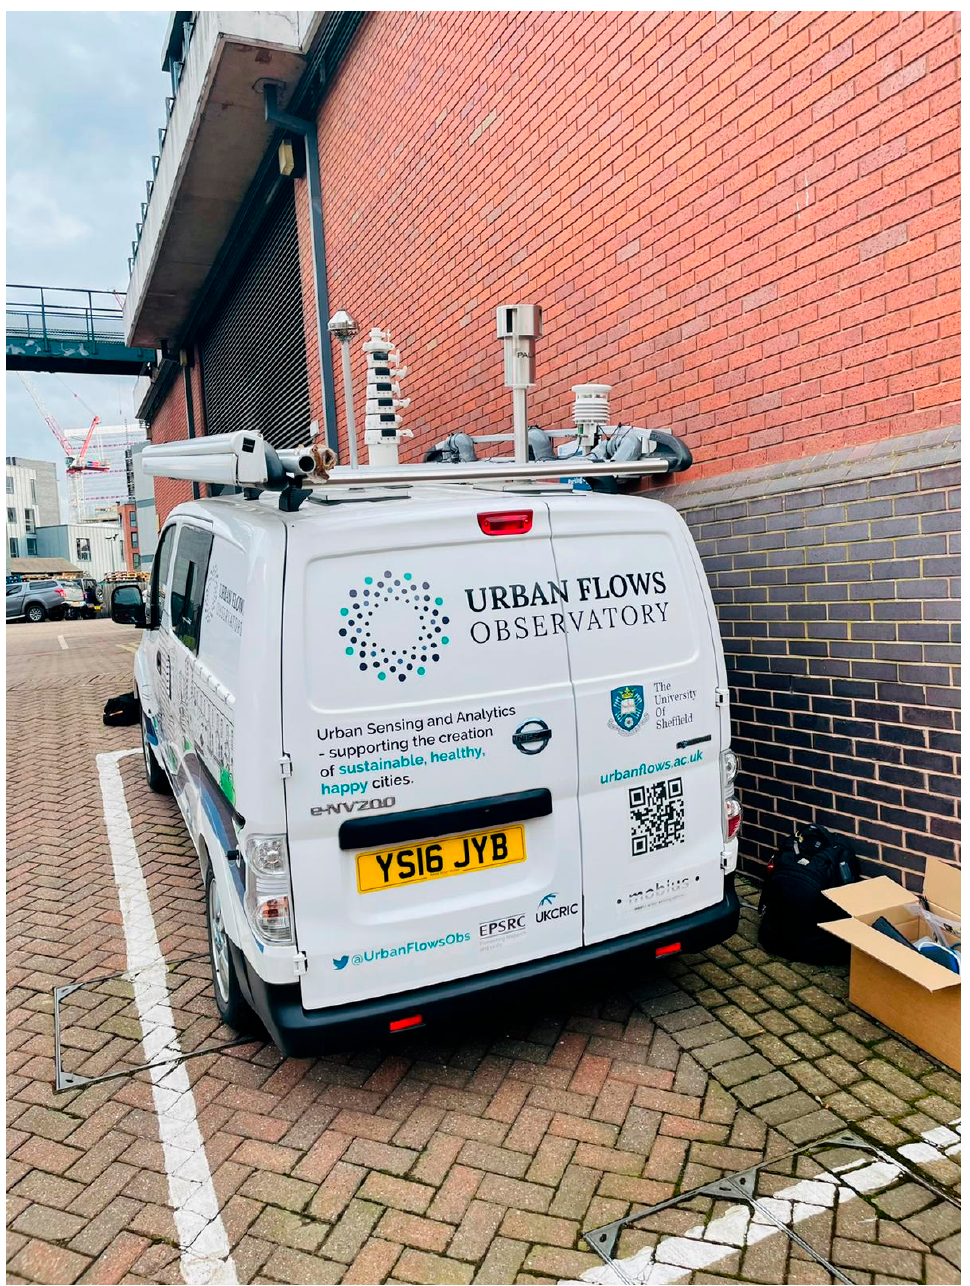
Figure 3. LCS-based AQ monitoring devices using RPi 3B+ at Urban Observatory, Sheffield Site.